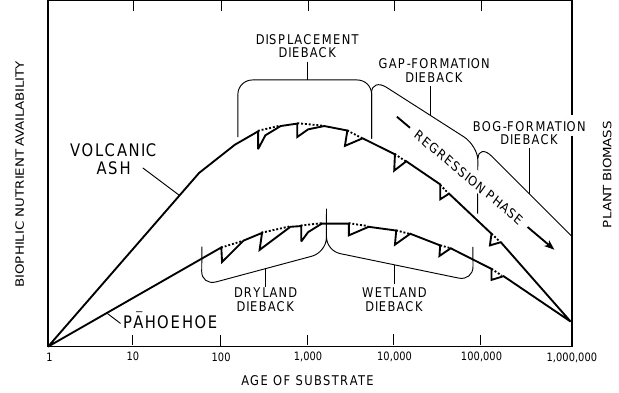
Fig. 12. A conceptual model of long-term primary succession of the two prevailing volcanic substrates in Hawaii with the five dieback types superimposed. Reproduced with permission from Annual Review of Ecology & Systematics 1986: 234.